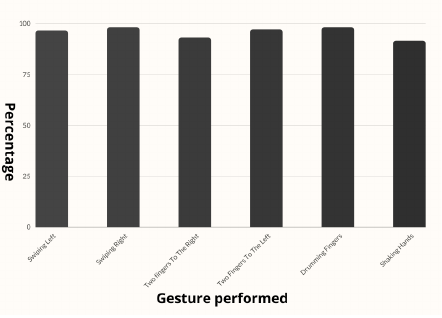
Fig 8. Analysis of the gesture